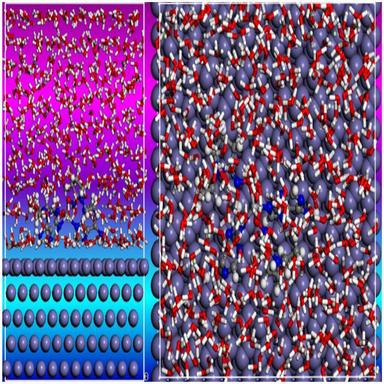
Side and top views of the final adsorption of tested inhibitors on the Fe (110) surface in solution.